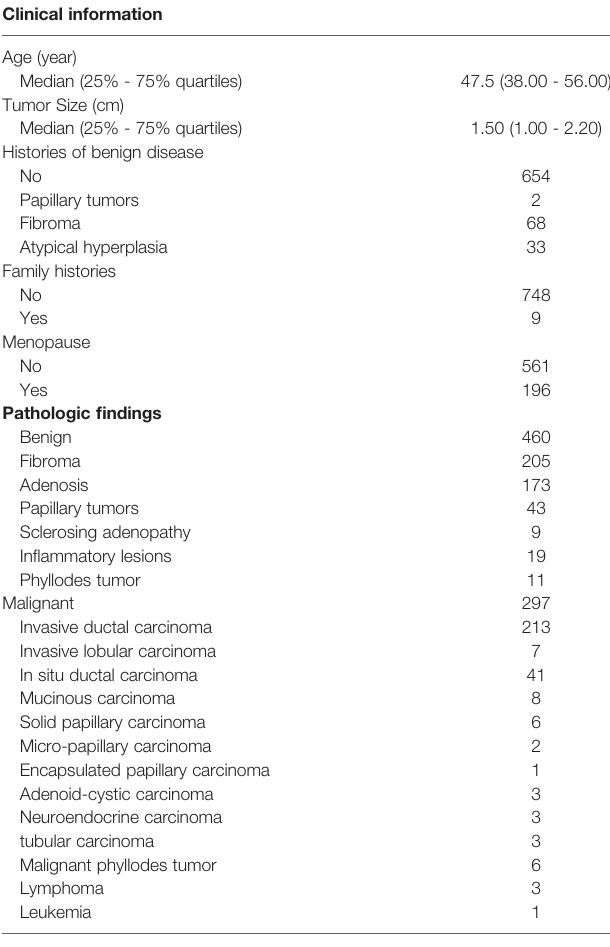
TABLE 1 | Clinical information and pathological results of the patients. Clinical information